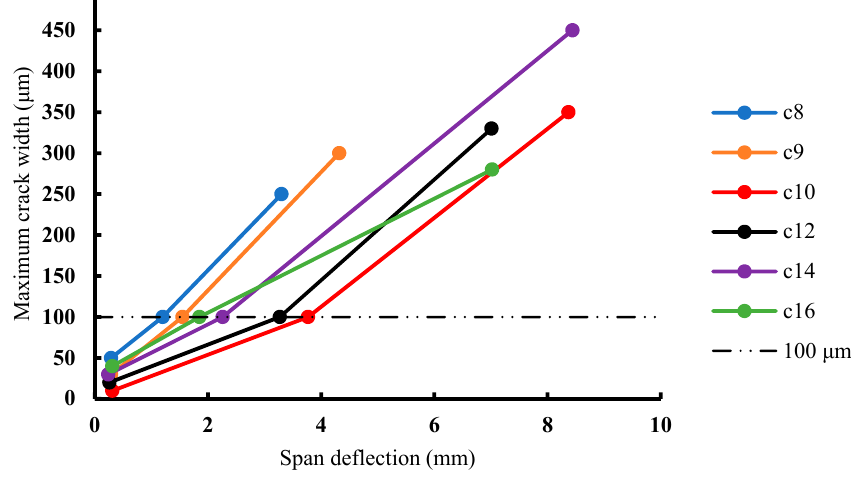
Figure 15. The maximum crack width–deflection curves of SSPP-ECC.